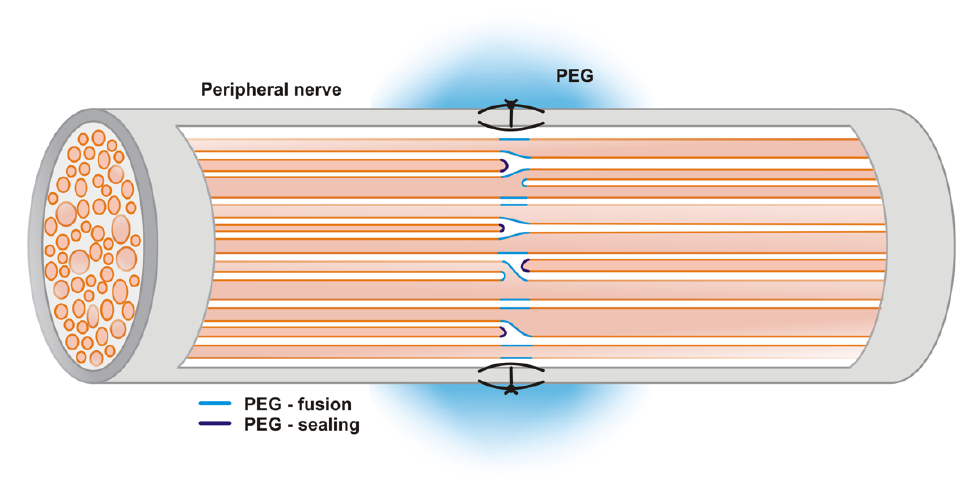
Figure 1. Mechanism of polyethylene glycol (PEG)-mediated fusion and sealing of axon ends. Polyethylene glycol application at the site of a nerve cut may result in either membrane fusion or membrane sealing.